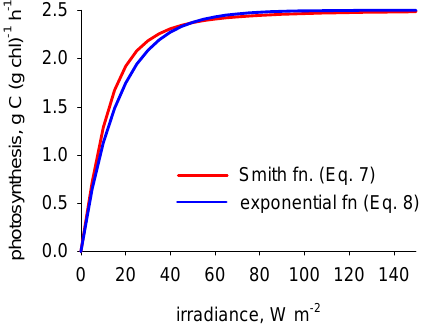
Figure 6. Triangular versus sinusoidal patterns of diel irradiance illustrated for a 12h day and noon irradiance of 200Wm − 2